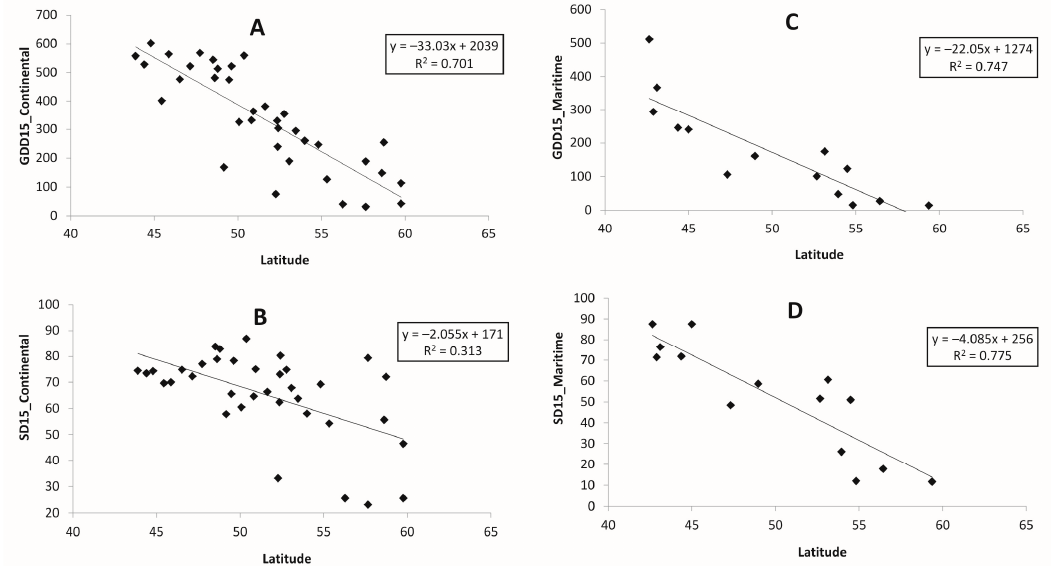
Figure 4. Relationship between growing degree days with 15 °C threshold (GDD15), its standard deviation (SD15) and latitude for locations in the Russian Far East for period 1966–2017: ( A , B ) continental weather stations, ( C , D ) maritime weather stations.